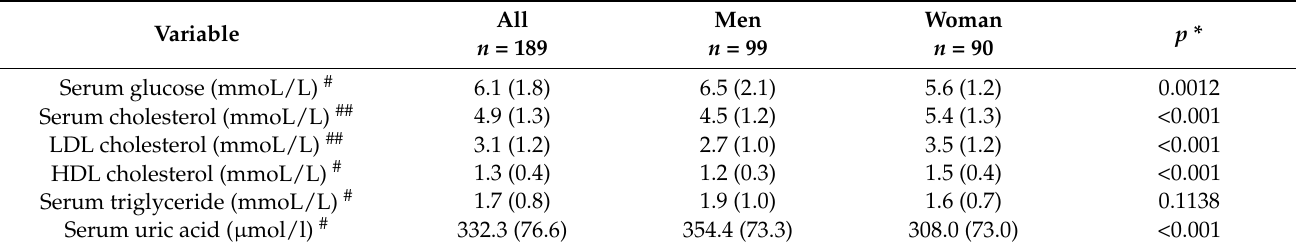
Table 2. Biochemical characteristics of study participants, Biomarker2019